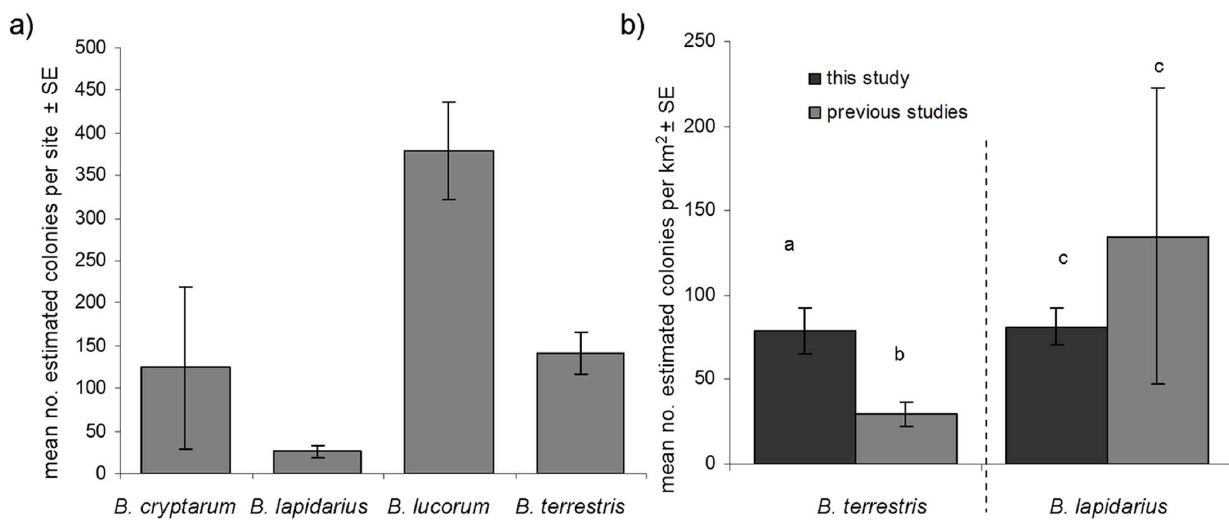
Figure 3. Mean numbers of colonies estimated foraging per field (a) and mean colony density per km 2 in comparison with previous work (b). Mean colony density per km 2 of Bombus terrestris was calculated using a foraging range of 758 m (n (our study)=12, n (previous studies)=5), and B. lapidarius using a foraging range of 450 m (n (our study)=7, n (previous studies)=12), and are provided in comparison to previous estimates ( B. lapidarius previous estimates data from Goulson et al. [25] and Knight et al. [31]. B. terrestris previous estimates data from a number of sources, summarised in Charman et al., [20]). Letters indicate significant differences (p , 0.05) determined using Kruskal-Wallis tests.